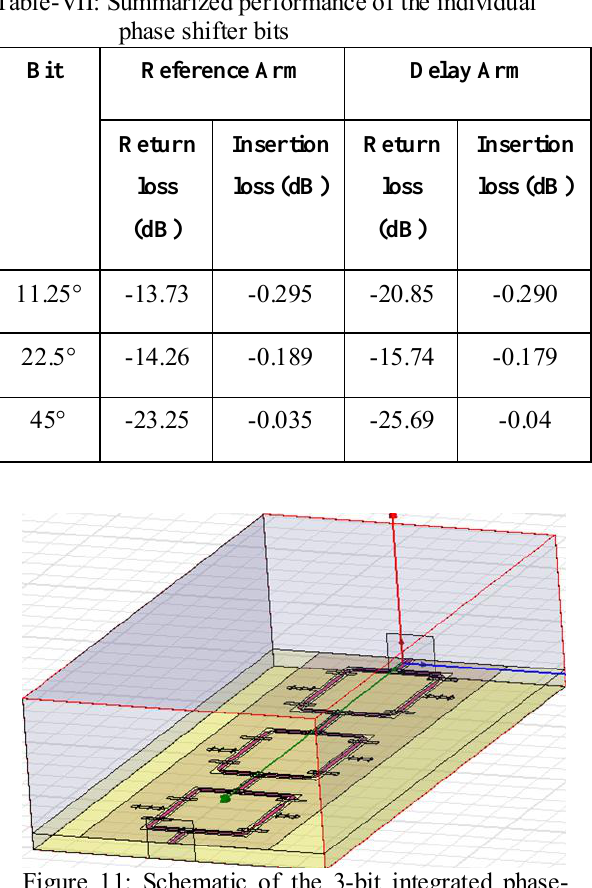
Table-VII: Summarized performance of the individual